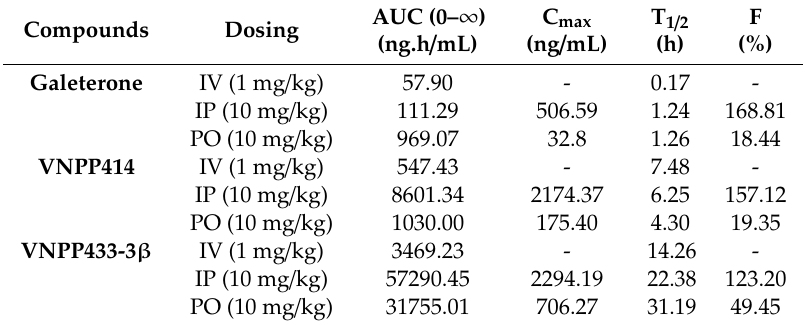
Figure 6. Plasma pharmacokinetic profiles of single IV, IP, and PO administrations of Gal, VNPP414 and VNPP433-3 β to CD-1 mice. Values represent mean (± SD) concentrations from three mice. Table 1. Pharmacokinetic parameters of Galeterone, VNPP414 and VNPP433-3 β after intravenous (IV), intraperitoneal (IP), or oral (PO) administration in male CD-1